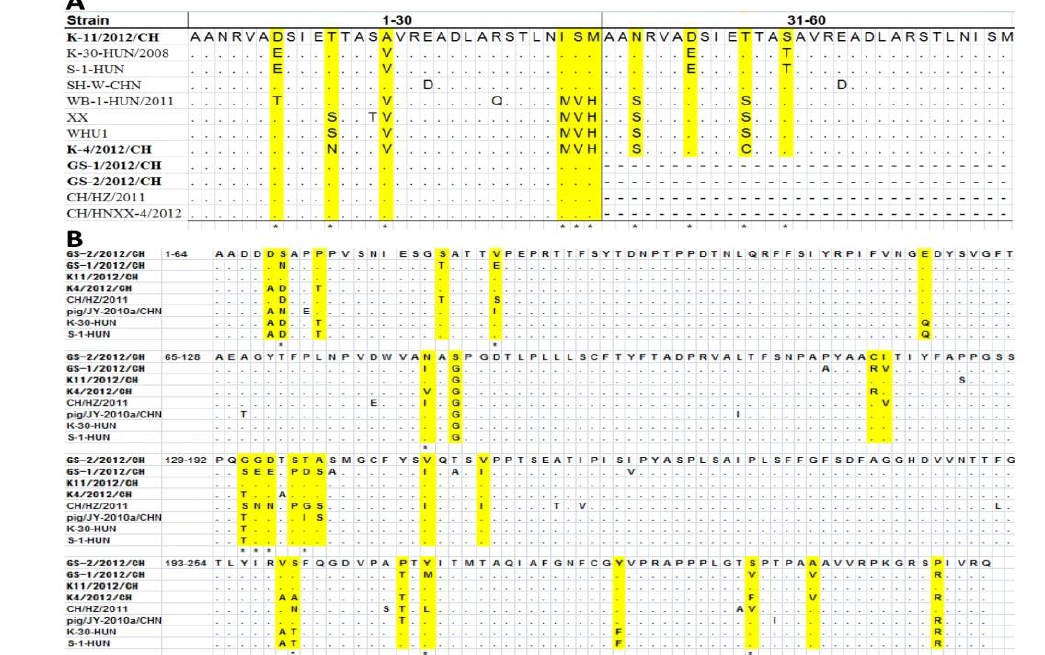
Figure 2. Comparison of the deduced protein amino acid sequences of the study strains and the reference strains. ( A ) Comparison of the deduced 2B protein amino acid sequences. An asterisk (*) indicates an amino acid substitution in the VP1 region; a dash (-) indicates an amino acid deletion in the variant strain; ( B ) Comparison of the deduced VP1 amino acid sequences. An asterisk (*) indicates no fewer than three amino acid substitutions within the VP1 region.